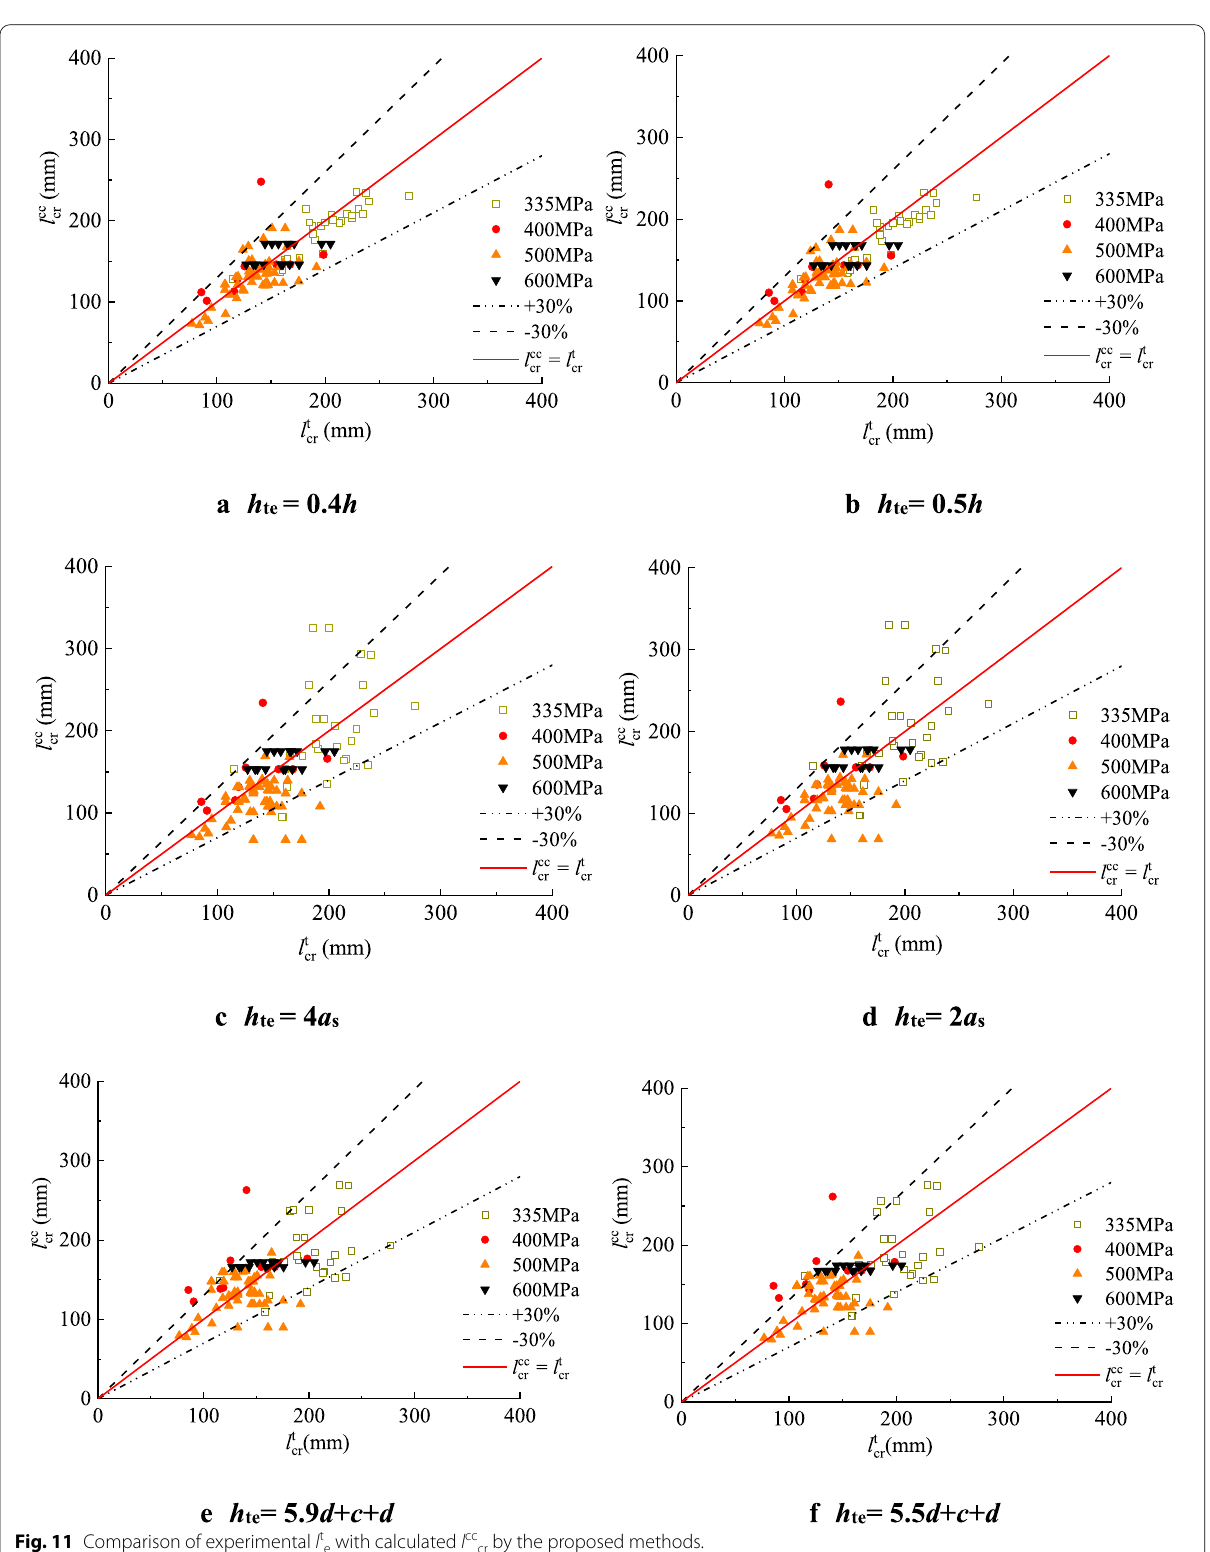
Fig. 11 Comparison of experimental l t e with calculated l cc cr by the proposed